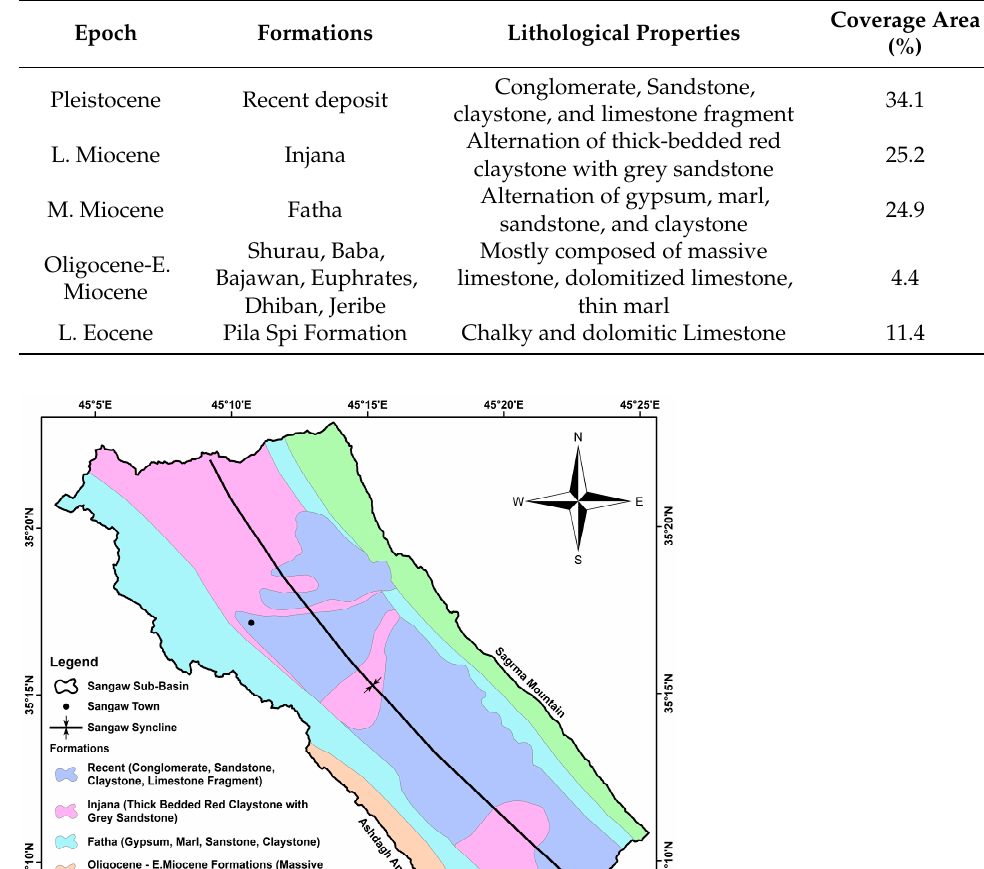
Table 1. Lithological characteristics of the existing formations in the study area.